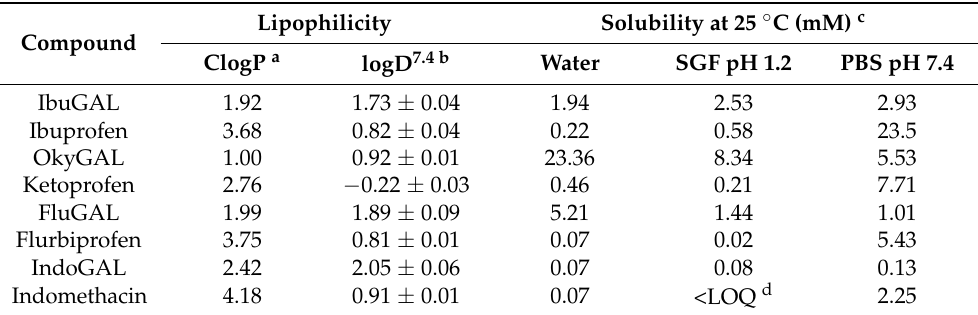
Table 1. Physicochemical characterization of galactosylated prodrugs and parent drugs: lipophilicity, calculated as log P (ClogP); experimental distribution coefficient at pH 7.4 (log D 7.4 ); and solubility (mM) in water, SGF (pH 1.2) and PBS (pH 7.4).